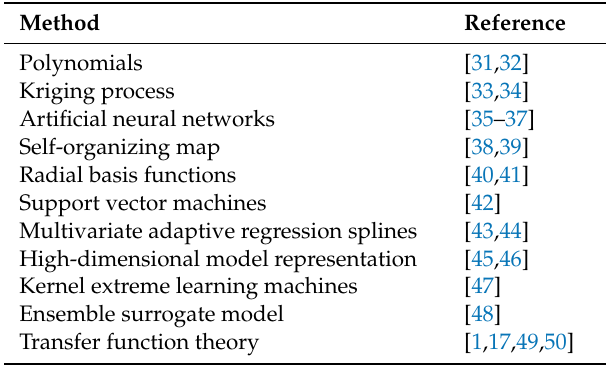
Table 1. Summary of data-driven models and related